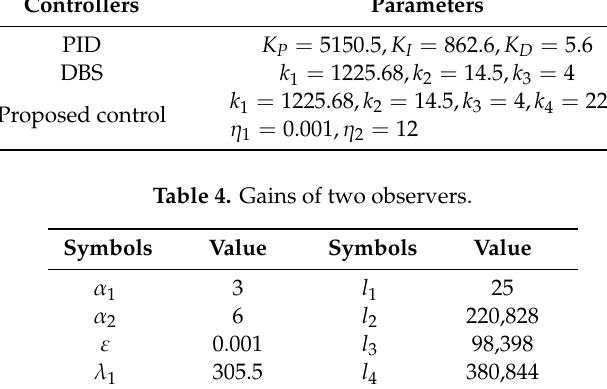
Table 3. Gains of controllers.